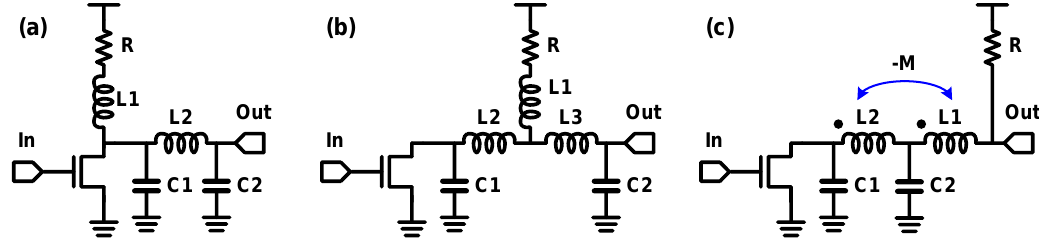
Figure 30. Circuit diagrams of ( a ) shunt and series peaking, ( b ) shunt and double-series peaking, ( c ) and T-coil peaking network. Sensors 2017 , 17 , 1962 24 of 39